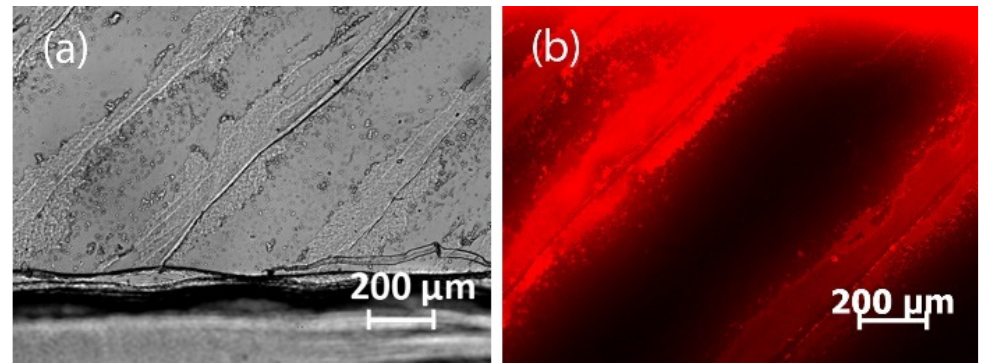
Figure 9. Surface area, next to a channel, of a microfluidic chip replicated from a casting mold fab- ricated with the Ultimaker S5. ( a ) 10× magnified. ( b ) 10× magnified with fluorescence visualization of rhodamine B solution—fluid flow along the grooves leaking from the channel at the upper side of the picture.